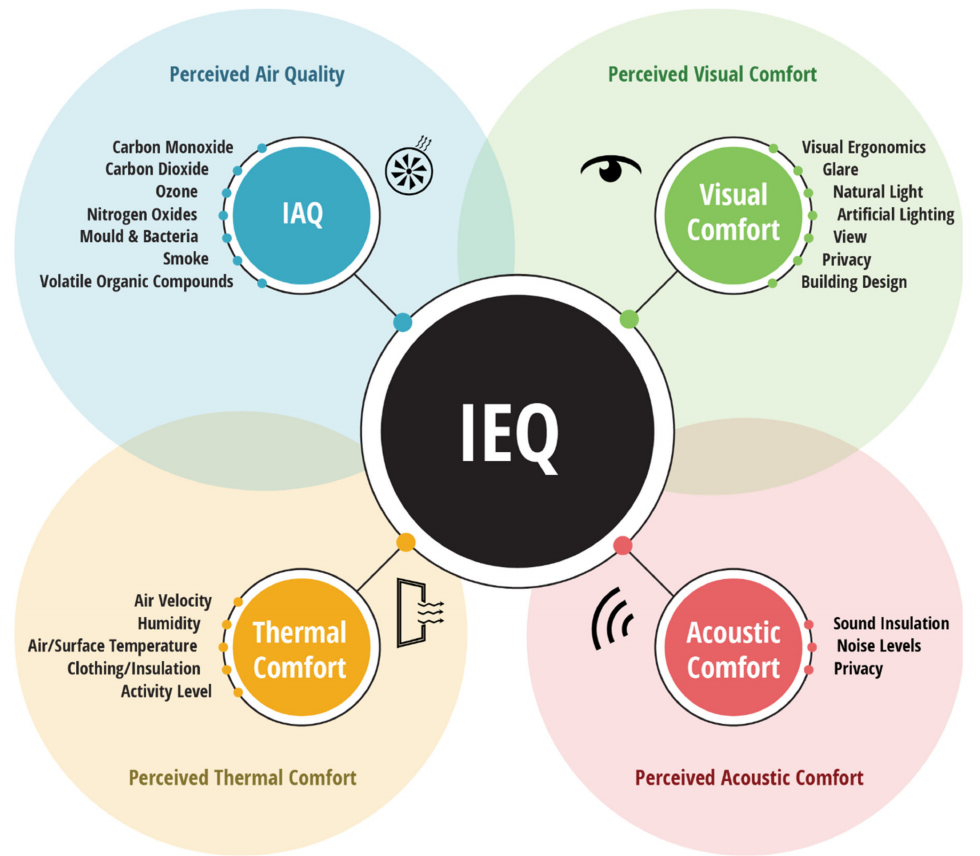
Figure 1. A holistic and general capture of terminologies and themes used across the literature to discuss IEQ.